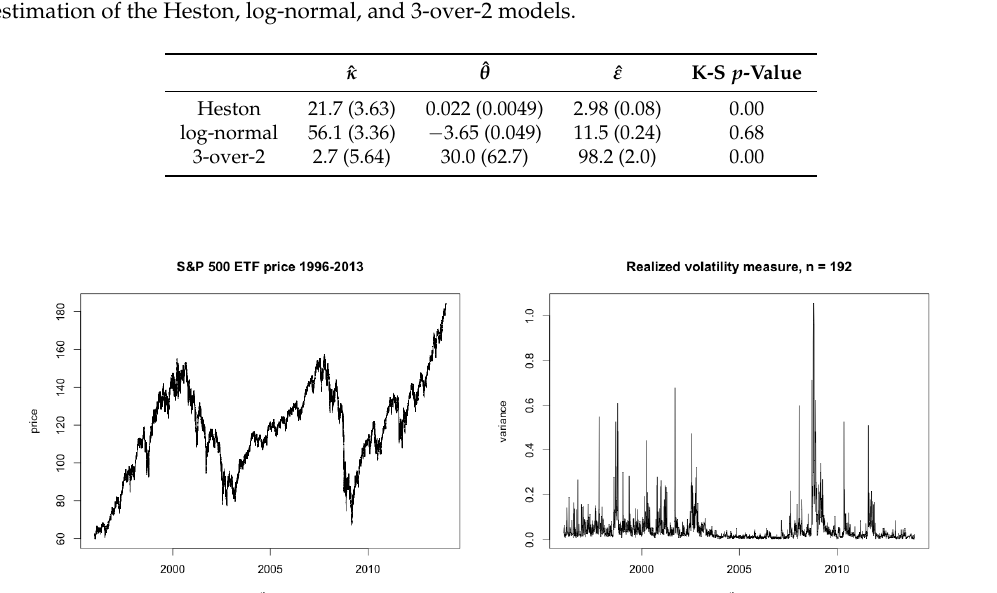
Figure 3. The left figure shows the S&P 500 ETF price from 2 January 1996 to 31 December 2013 with a 5-min. frequency and a total of 368,724 observations. Right figure: variance of the S&P 500 ETF price measured by realized volatility with frequency n = 192 and a total of 1920